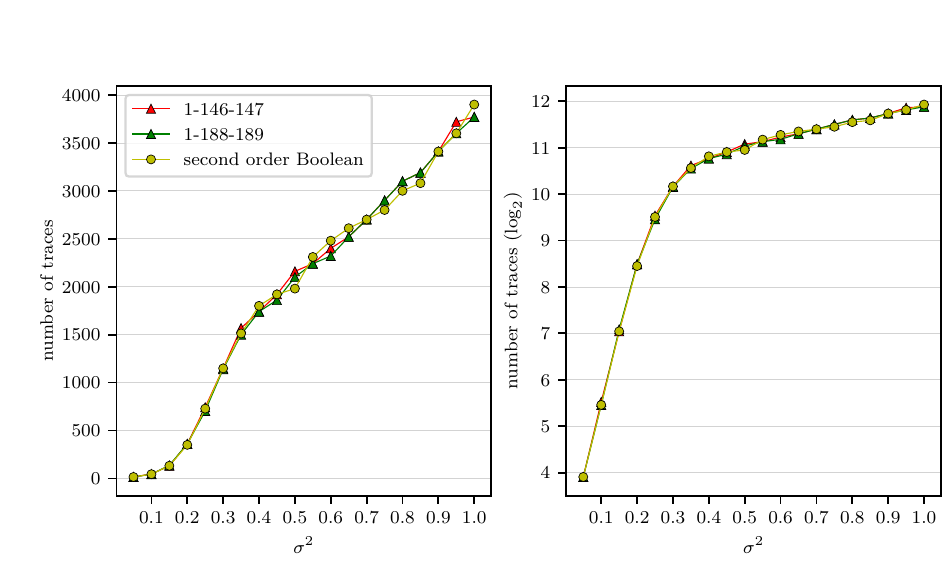
Figure 5: Attacks on "boolean case" (3,2) polynomial masking and second order